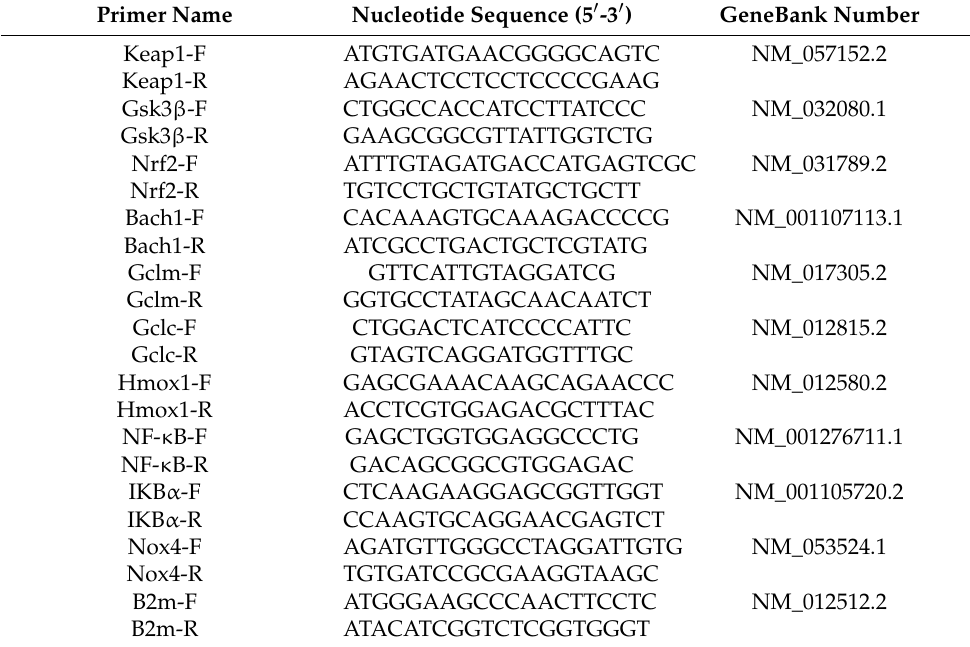
Table 2. Primers and GeneBank accession number for real-time